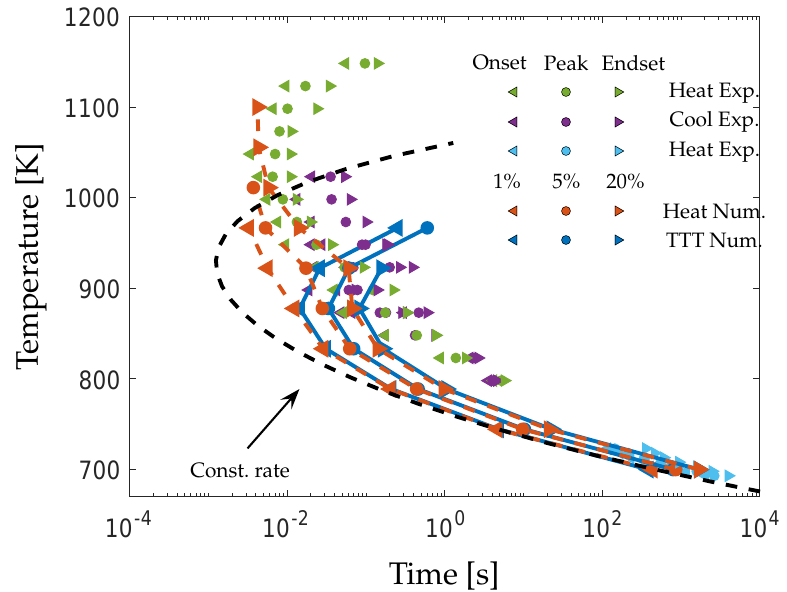
Figure 4. Numerically obtained TTT-diagrams of the CuZr 2 phase from a matrix composition of Al 10 Cu 30 Zr 60 during heating followed by holding (red) and isothermal simulations (dark blue). The onset, peak and endset of the flash DSC measurements on AMZ4 obtained upon heating (green) and cooling (purple) followed by holding as presented in [47] are included for comparison. Low- temperature DSC measurements on AMZ4 are also included [45]. The black dashed line shows the computed TTT-diagram using the maximum growth rate from Figure 3 as a constant